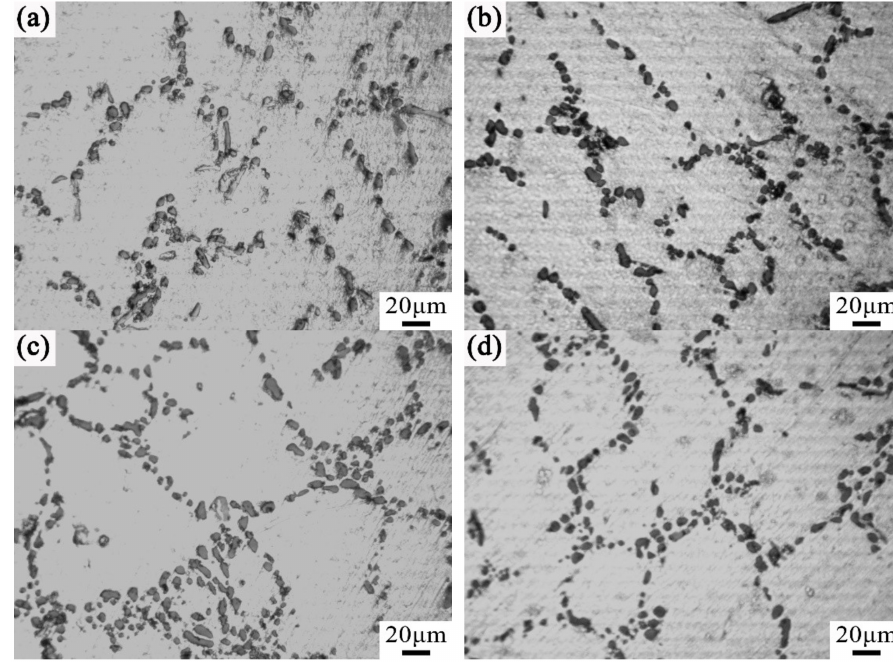
Figure 5. The microstructure of the Al-7Si-0.55Mg alloy with di ff erent pulse currents at a pulse